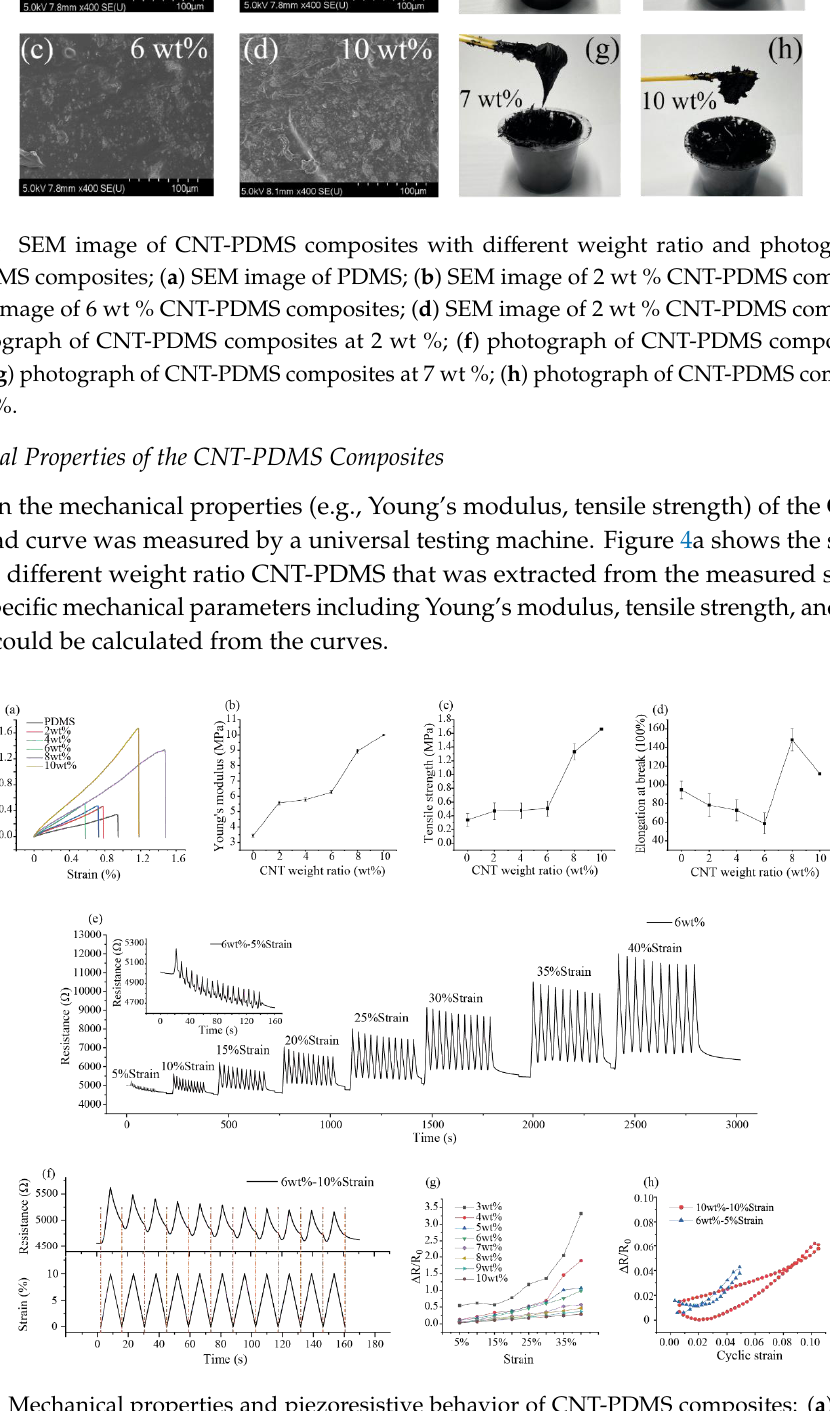
Figure 4. Mechanical properties and piezoresistive behavior of CNT-PDMS composites: ( a ) typical tensile stress – strain curves; ( b ) Young’s modulus ; ( c ) tensile strength; ( d ) elongation at the break; ( e ) change in resistance upon the strain of the 6 wt% CNT-PDMS sample; ( f ) typical piezoresitive behavior of the CNT-PDMS composites sample (6 wt%), 10 strain; ( g ) resistance change of CNT-PDMS composites with different CNT weight ratios; ( h ) resistance during the stretching−releasing cycle. Table 1. Mechanical properties of composites.